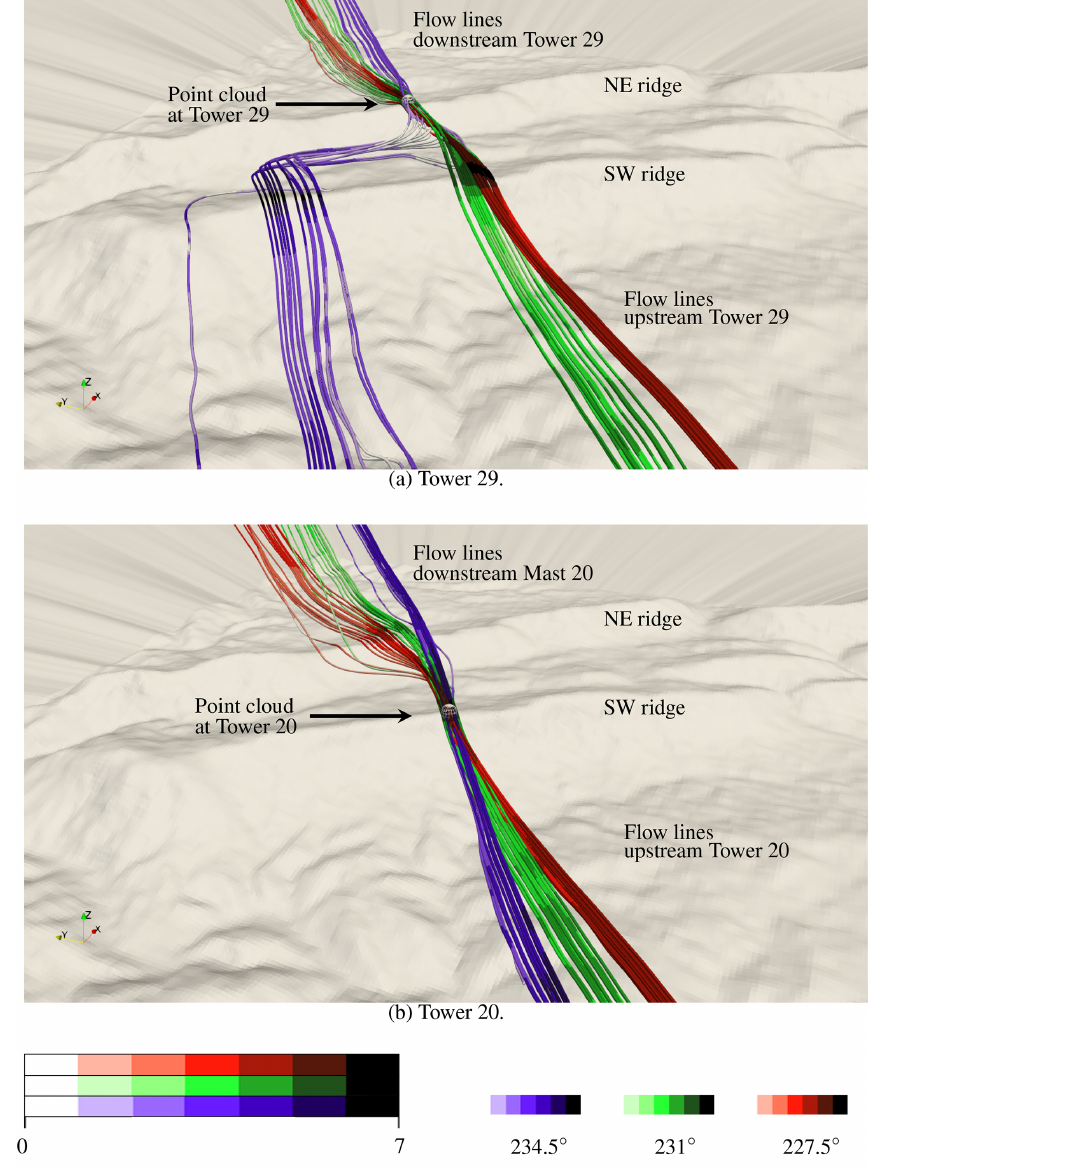
Figure 22. Wind paths of air parcels passing through a sphere of 55m radius placed on top of the ground at given met-mast locations. Flow lines colored in green represent trajectories for wind coming from 231 ◦ at the inlet, while red and blue lines illustrate wind at the inlet from 227.5 and 234.5 ◦